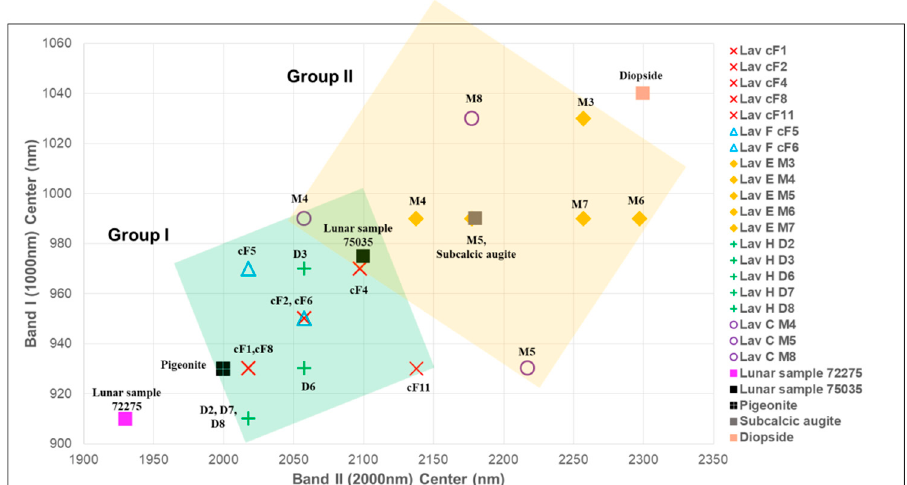
Figure 9. The reflectance features of the crater floor materials, mare basalts, and the dark mantle deposits (Figure 5 to Figure 8) on the five crater floors. They show the locations of band I (1000 nm) center and band II (2000 nm) center of the reflectance spectra. The colors for each point follow as: (crater floor, cF) cF1, cF2, cF4, cF8, and cF11 in the Lavoisier Crater (Lav)—red crosses, cF5 and cF6 in the Lavoisier F Crater (Lav F)—blue triangles (Figure 5), M3, M4, M5, M6, and M7 in the Lavoisier E Crater (Lav E)—orange diamonds (mare basalts, M) (Figure 6), D2, D3, D6, D7, and D8 in the Lavoisier H Crater (Lav H)—green crosses (dark mantle deposits, D) (Figure 7), M4, M5, and M8 in the crater Lavoisier C (Lav C)—purple circles (Figure 8), lunar sample 72275—pink square (orthopyroxene), lunar sample 75035—black square (subcalcic augite), pigeonite—black square, subcalcic augite—grey square, diopside—orange square. The five samples (diamonds and triangles) are adopted from Adams [52]. The overlapping points are as follows: Lavoisier (Lav) cF1, cF2, and cF8, Lavoisier F (Lav F) cF6, Lavoisier H (Lav H) D2, D7, and D8.